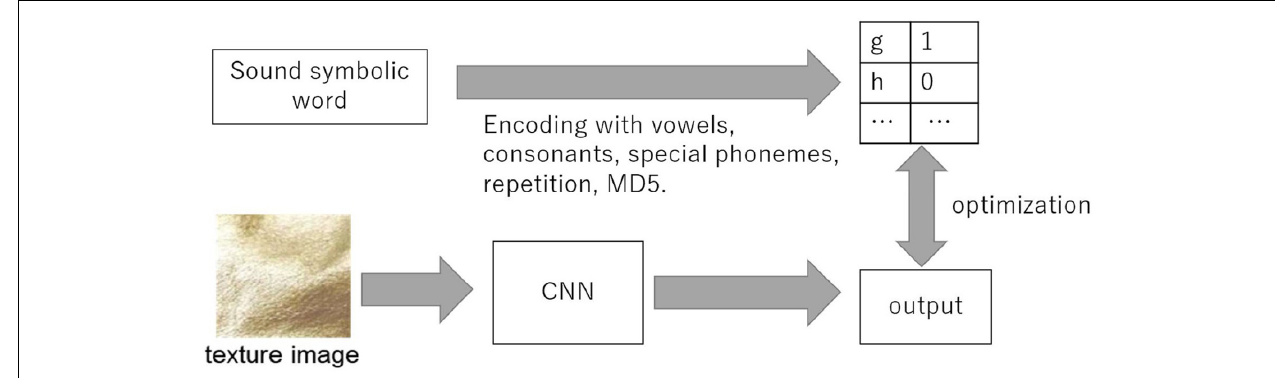
FIGURE 2 | Overview of our